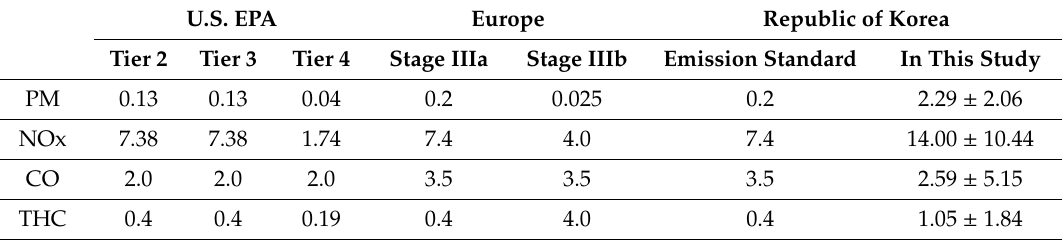
Table 4. Emission allowance standards of major